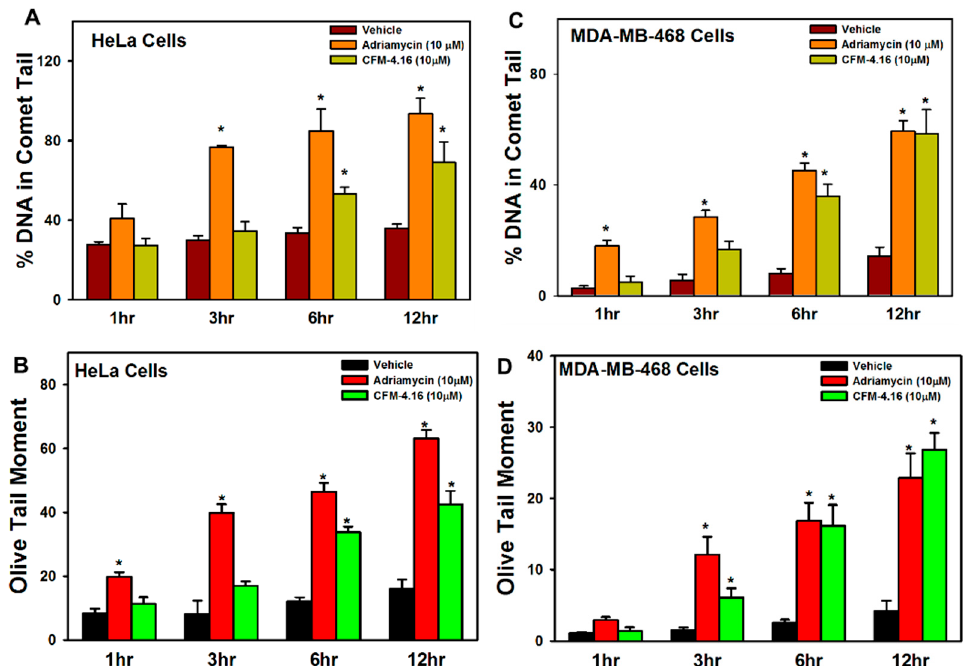
Figure 2. Adriamycin and CFM-4.16 induce DNA damage. Cells were treated with the noted dose of respective compound for indicated time periods. Mean values for percentage tail DNA content ( A , C ) and Olive tail moment ( B , D ) for respective cells from control and treatment periods for each compound were measured using software recommended by the manufacturer of the kit for measurement of DNA damage (Cell Bio Labs, CA, USA). The columns in each chart indicate average values for respective treatment condition; bars, SE; * p ≤ 0.05.